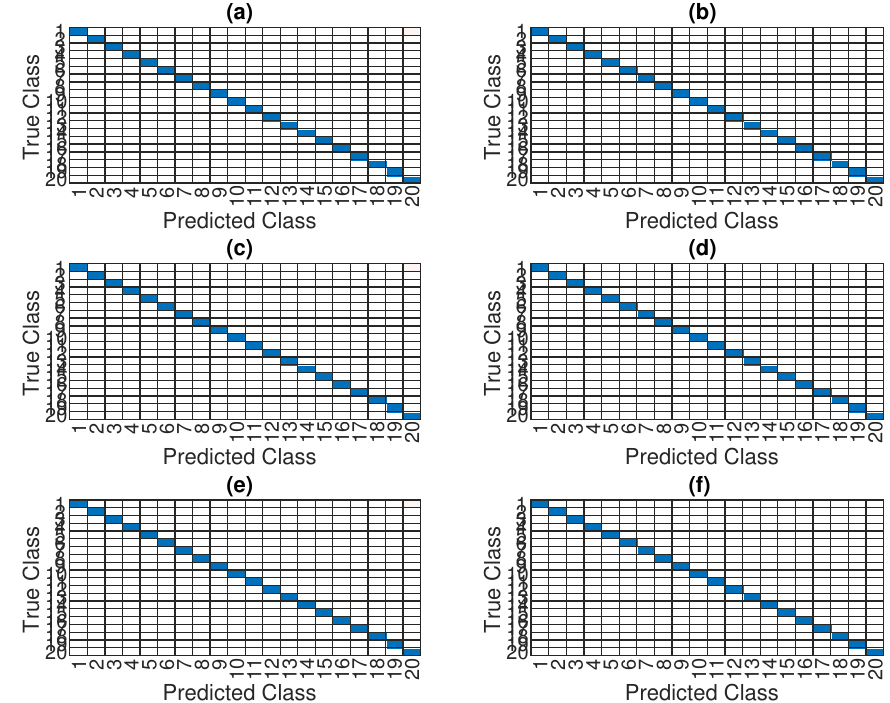
Figure 9. Confusion matrix of the CAE method for output angles versus incident angles at 10 dB SNR: ( a ) the subregion of the incident angle in [ − 60, − 40), ( b ) the subregion of the incident angle in [ − 40, − 20), ( c ) the subregion of the incident angle in [ − 20, 0), ( d ) the subregion of the incident angle in [0, 20), ( e ) the subregion of the incident angle in [20, 40), ( f ) the subregion of the incident angle in [40,